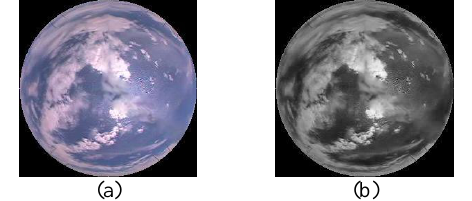
Figure 3. RAS feature: (a) Original image and (b) RAS image